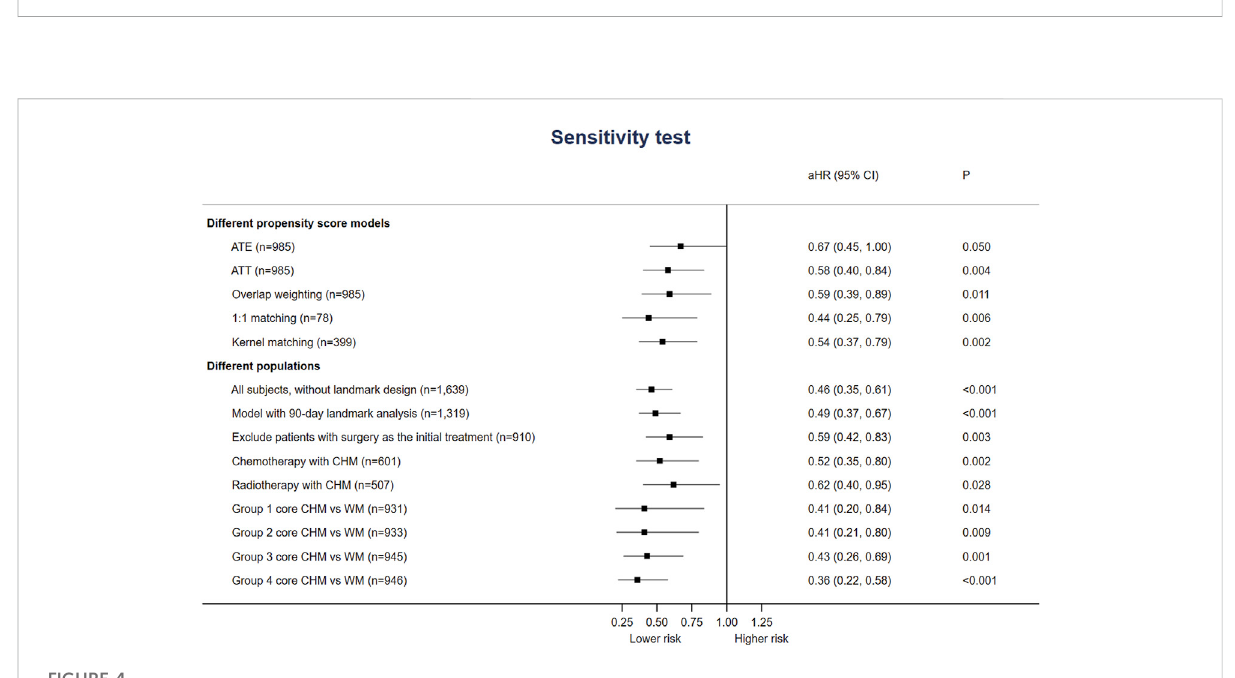
FIGURE 4 Sensitivity and subgroup analysis for overall survival estimation of CHM